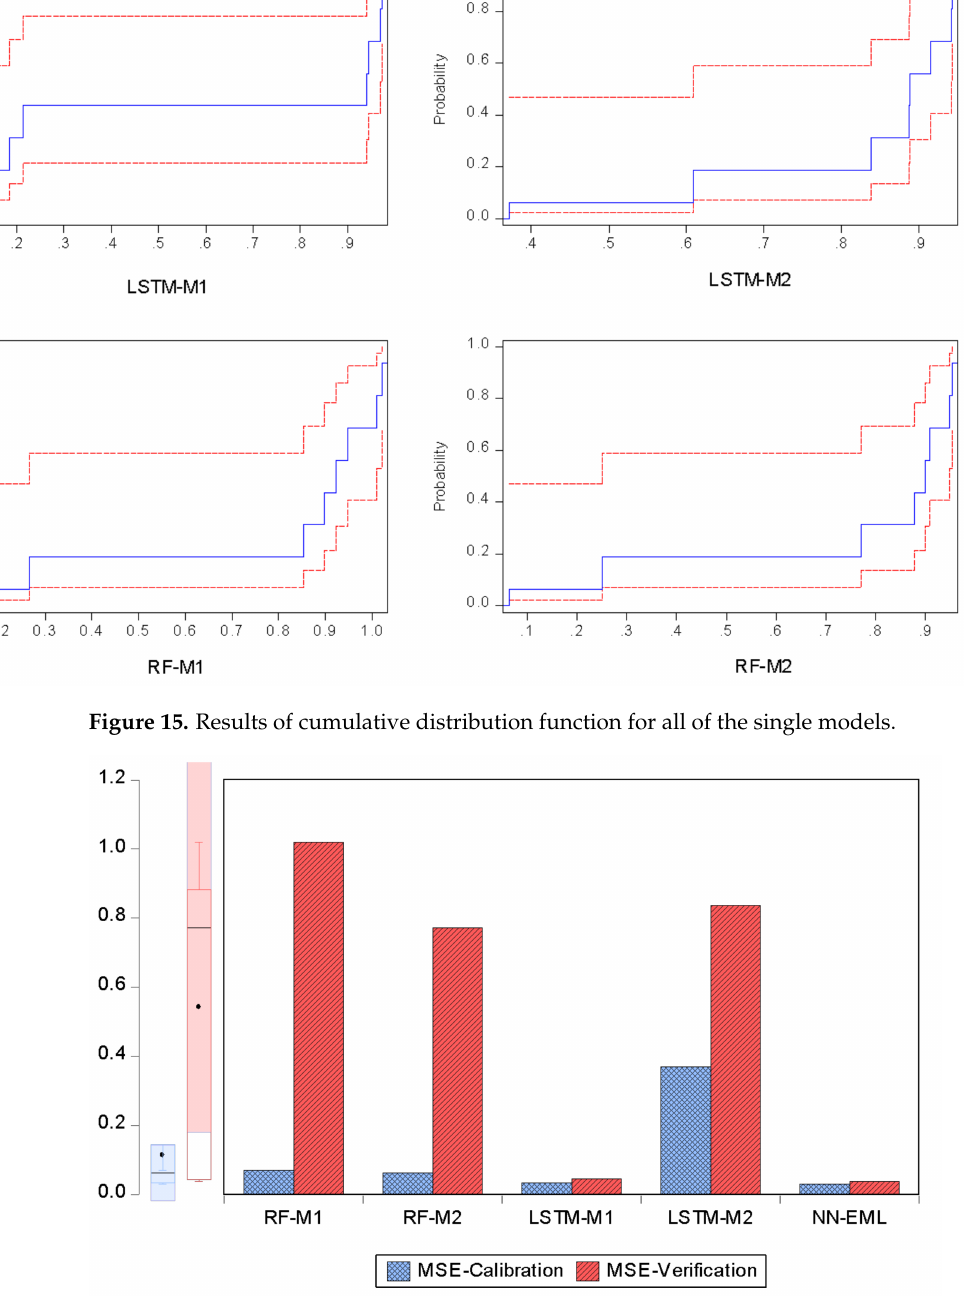
Figure 16. Error performance in term of MSE for all of the